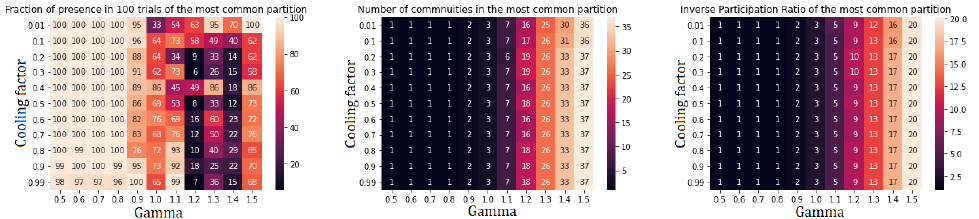
Figure A3. Performance indicators for Spin Glass algorithm applied to community III. There is no further subdivision.